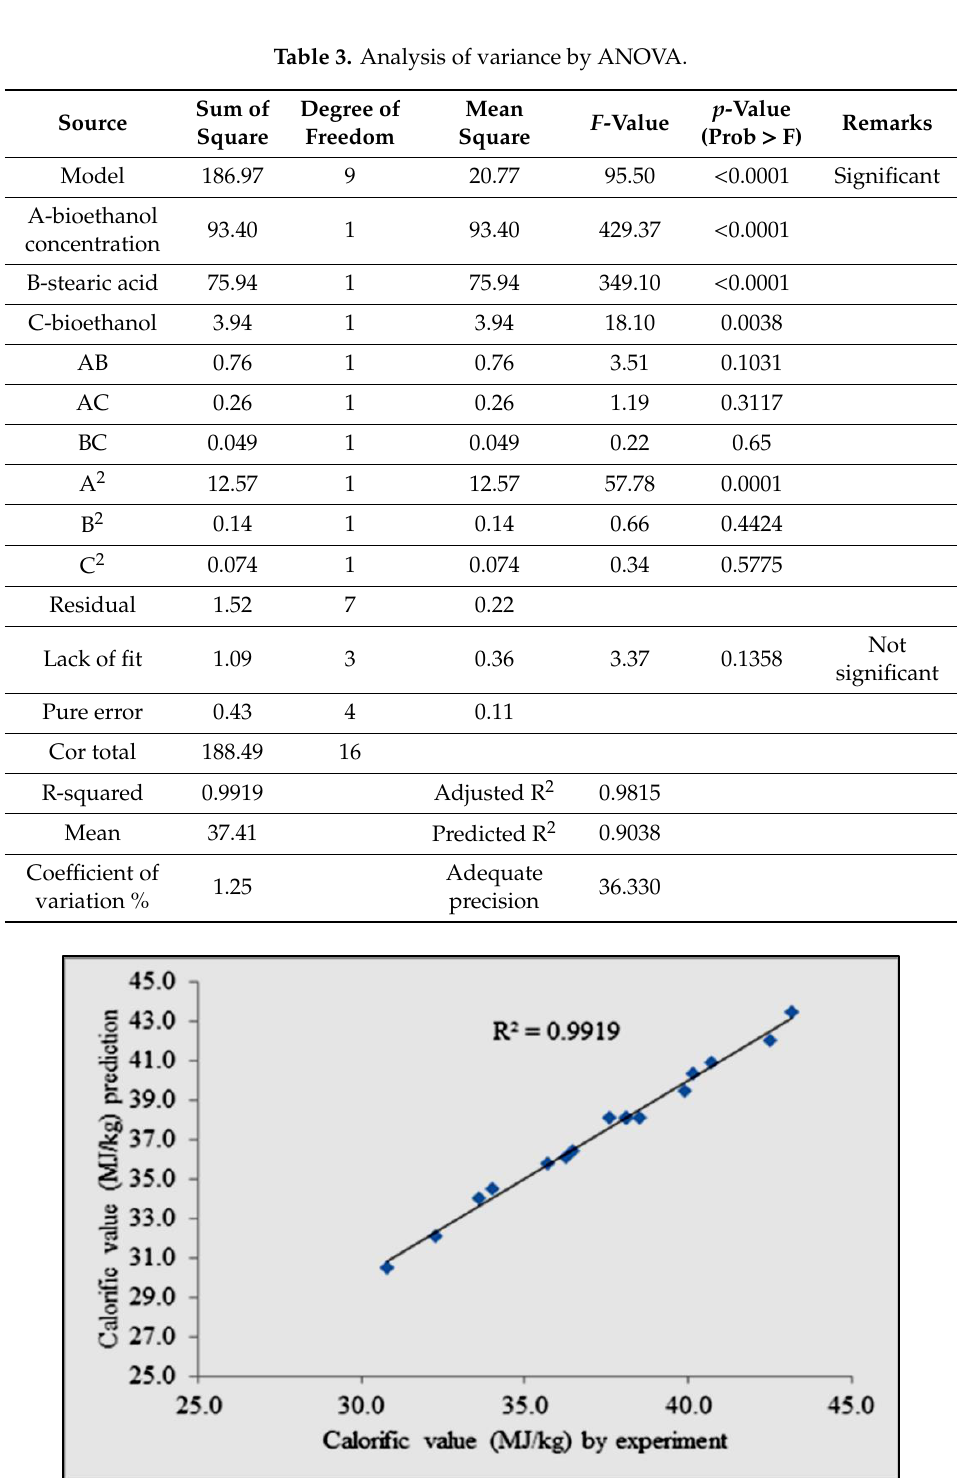
Figure 4. Plot of experimental and predicted calorific value.